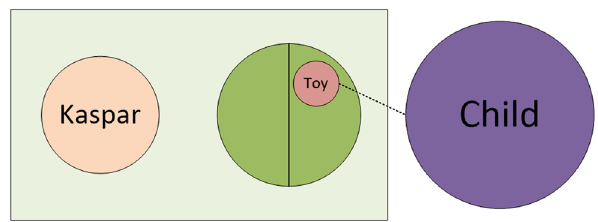
Figure 6: Equipment layout for Game